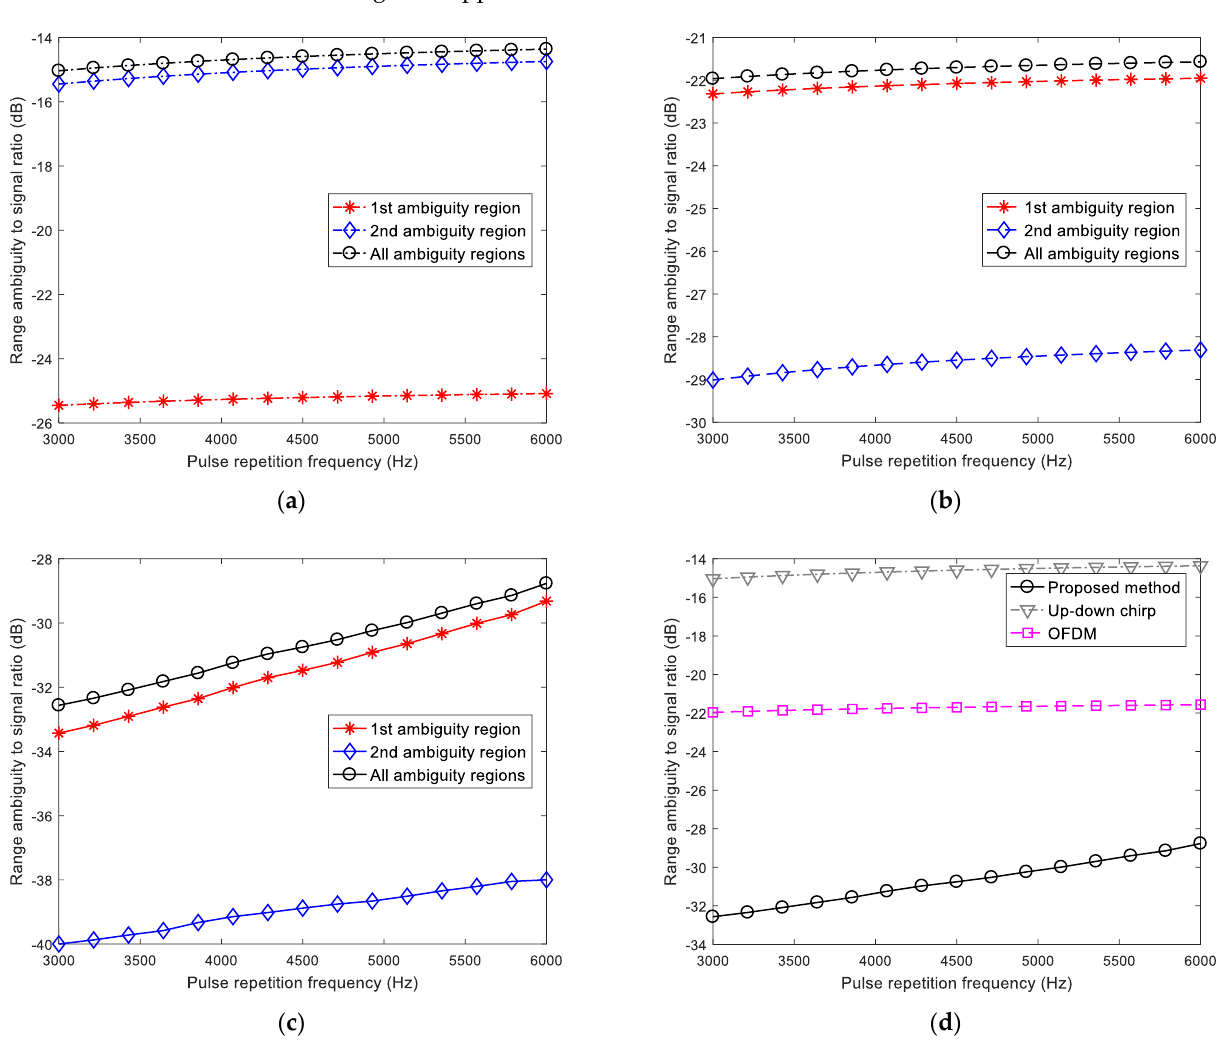
Figure 7. Range-ambiguity-to-signal ratio versus PRF: ( a ) the up-down chirp method; ( b ) the OFDM method; ( c ) the proposed method; ( d ) different methods for all ambiguous regions. method; ( c ) the proposed method; ( d ) different methods for all ambiguous